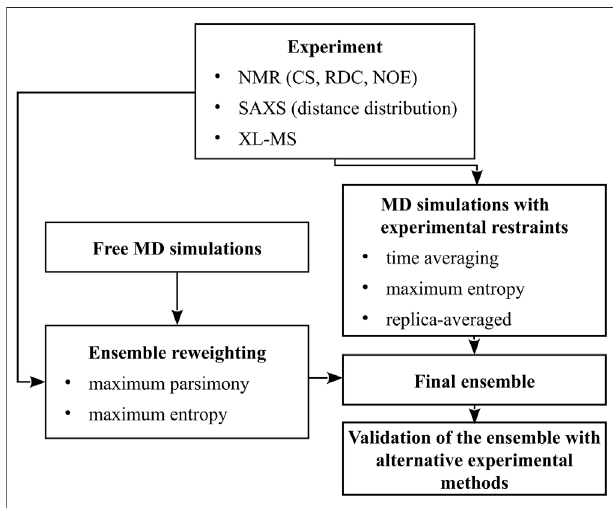
FIGURE 1 | A scheme of methods for the determination of conformational ensembles of fl exible